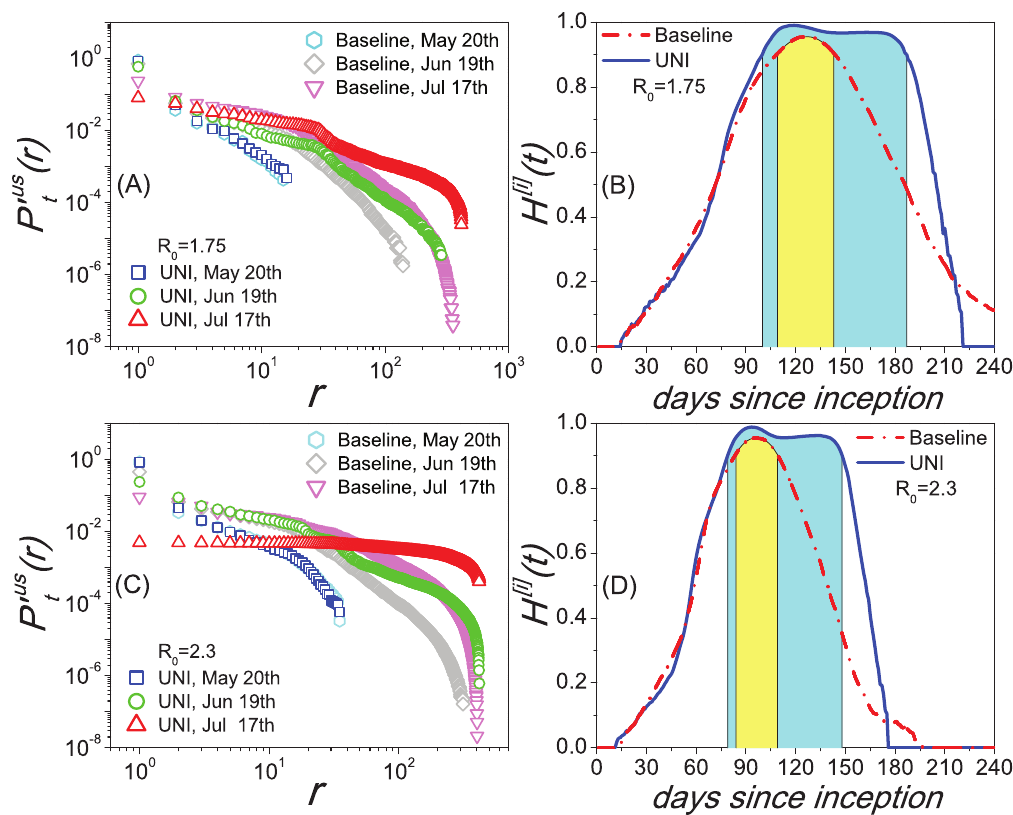
Figure 3. Comparisons of the scaling properties between the UNI scenarios and the baseline cases. (A,C) present the comparison of the PRD P ’ us ( r ) of the CCN of every infected MSA/ m SA between the baselines and the UNI scenarios at several given date sampled about every 30 days t when R 0 ~ 1 : 75, R 0 ~ 2 : 3 , respectively. (B,D) present the comparison of the information entropy profiles between the baselines and the UNI results when R 0 ~ 1 : 75, R 0 ~ 2 : 3 , respectively. Each data in these figures are the median results over all runs that led to an outbreak at the U.S. level in 100 random Monte Carlo realizations.